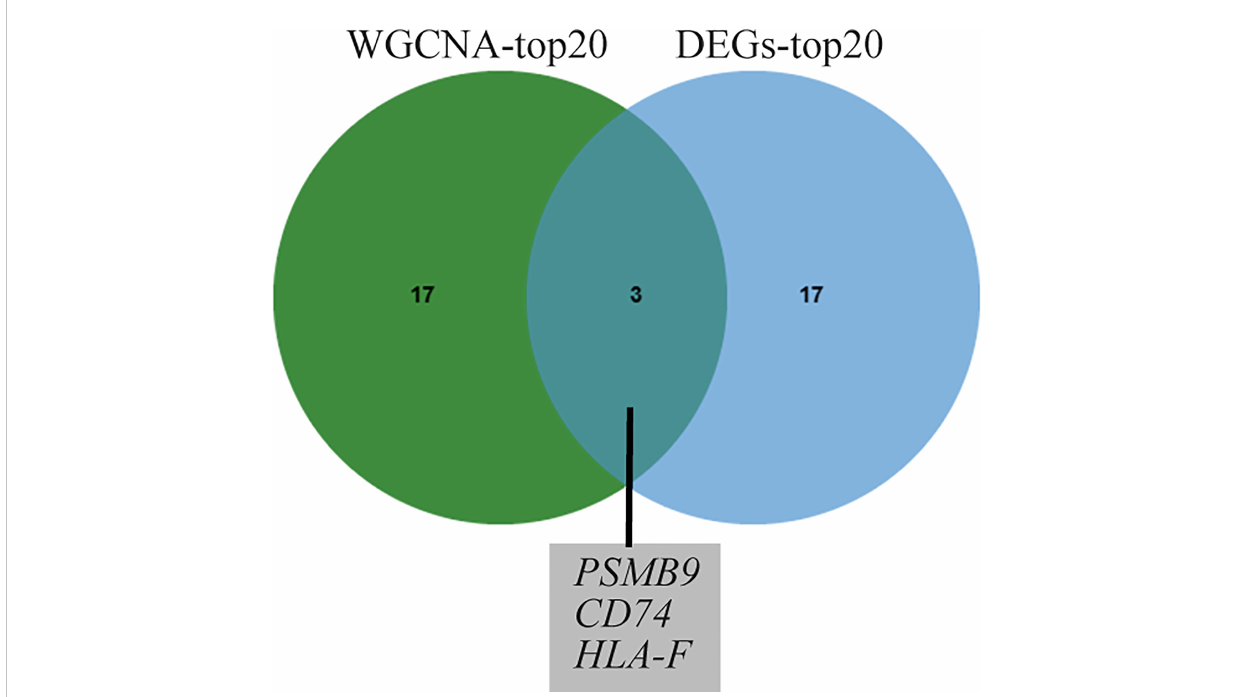
FIGURE 4 Venn diagram of common genes from the top 20 hub genes of WGCNA and DEG analysis. WGCNA, weighted gene coexpression network analysis; DEGs, differentially expressed